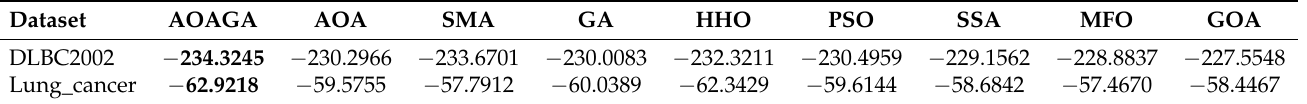
Table 11. Real Application: Average of the fitness